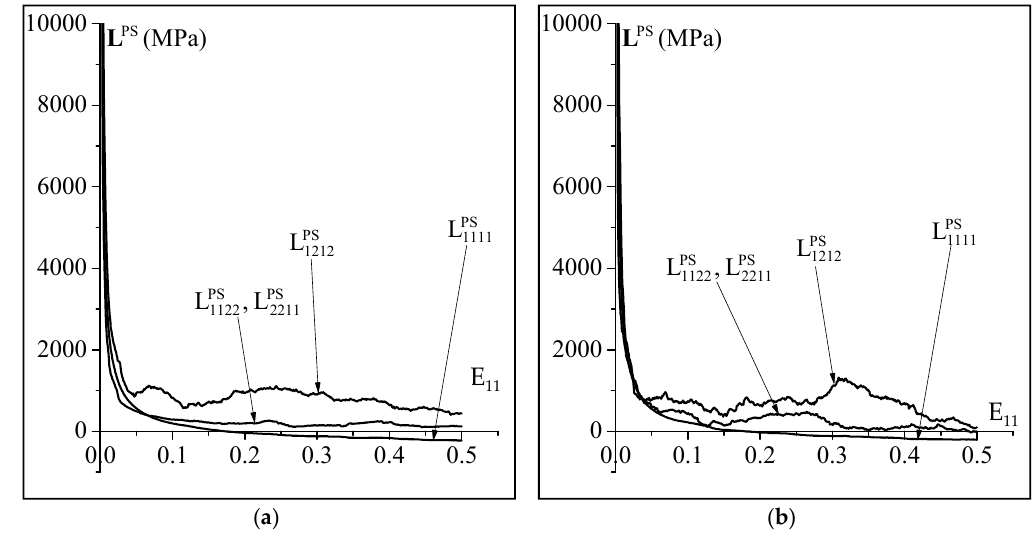
Figure 4. Significance of the non-Schmid effects on the evolution of some representative components of the macroscopic tangent modulus for the plane-strain state: ( a ) Results without non-Schmid effects (a 1 = a 2 = a 3 = 0); ( b ) Results with non-Schmid effects (a 1 = 0.2;a 2 = a 3 = 0).